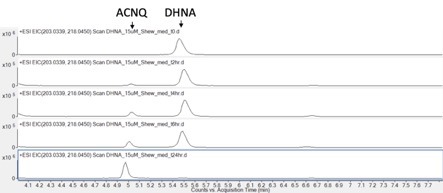
DHNA conversion to ACNQ in the same minimal media that was used to culture MR-1.No DHNA was observed after 24 hr of incubation at room temperature under aerobic conditions.